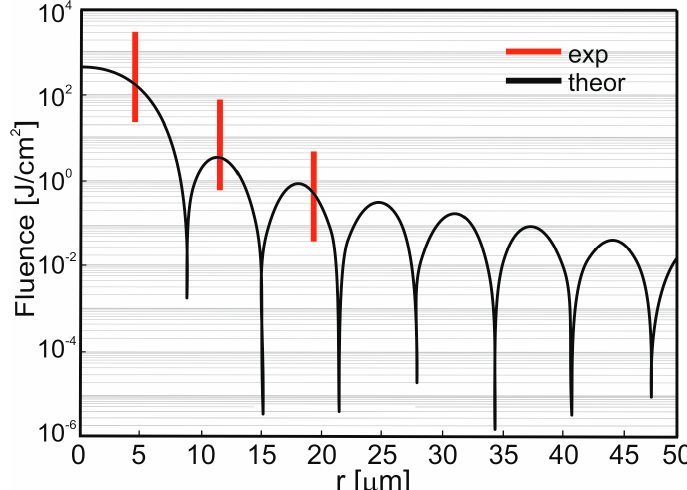
Figure 9. Distribution of laser beam fluence in the focal plane for total pulse energy 200 µJ. The red lines mark the radius of the central hole and position of the maxima of the diffraction rings determined as in Figure 7.